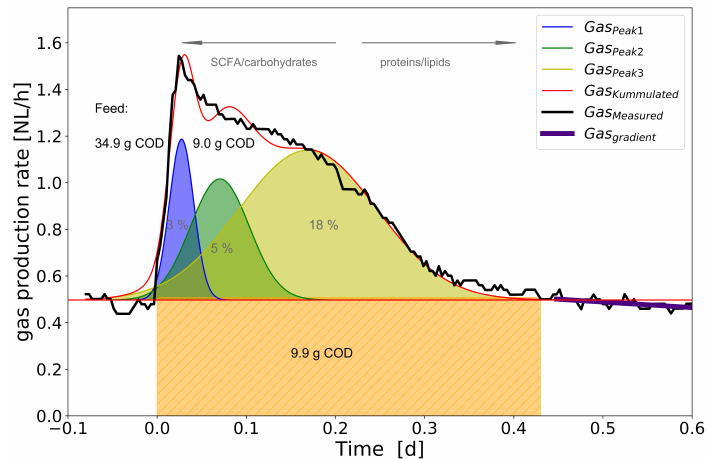
Figure 3. Deconvolution of gas production rate curve 7 into three gaussian functions; COD-balance: Percentages represent the share of the COD-equivalents of the deconvoluted peaks on the amount of COD of the feed. For better illustration the course of gas production rate was